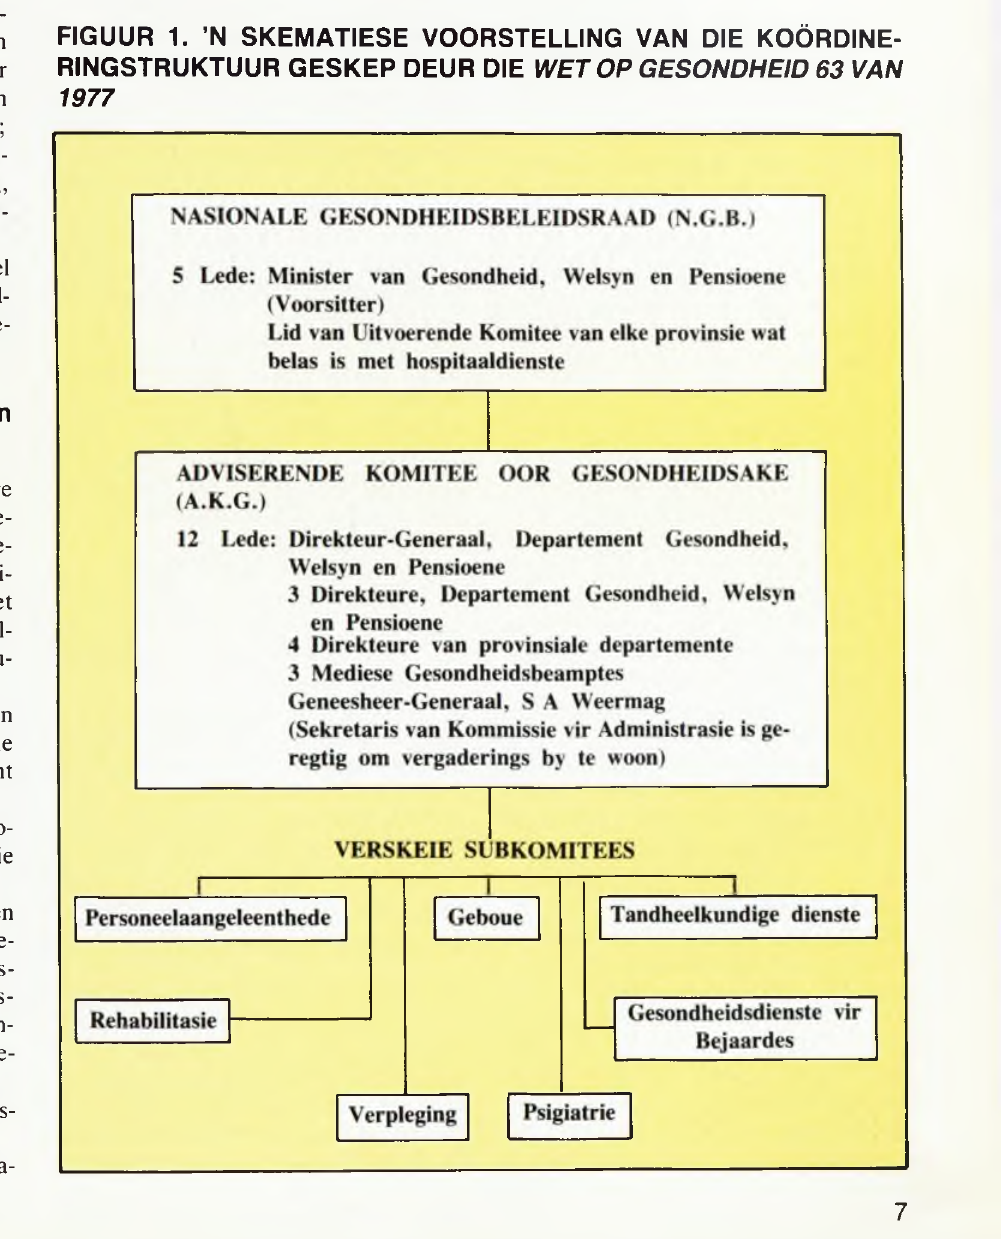
FIGUUR 1. ’N SKEMATIESE VOORSTELLING VAN DIE